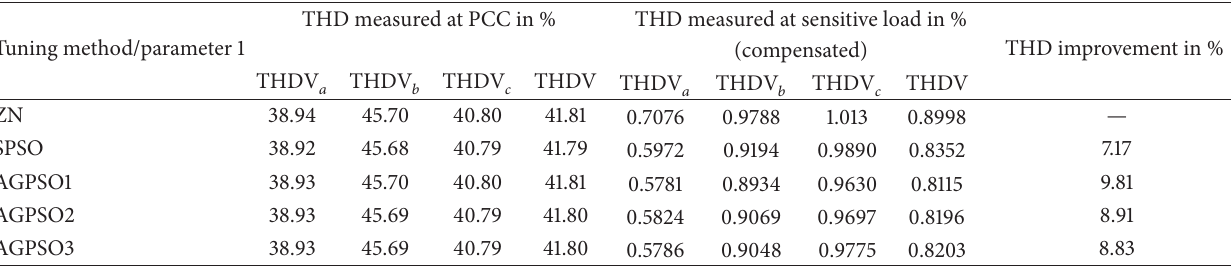
Table 5: Harmonic mitigation of rectifier load.